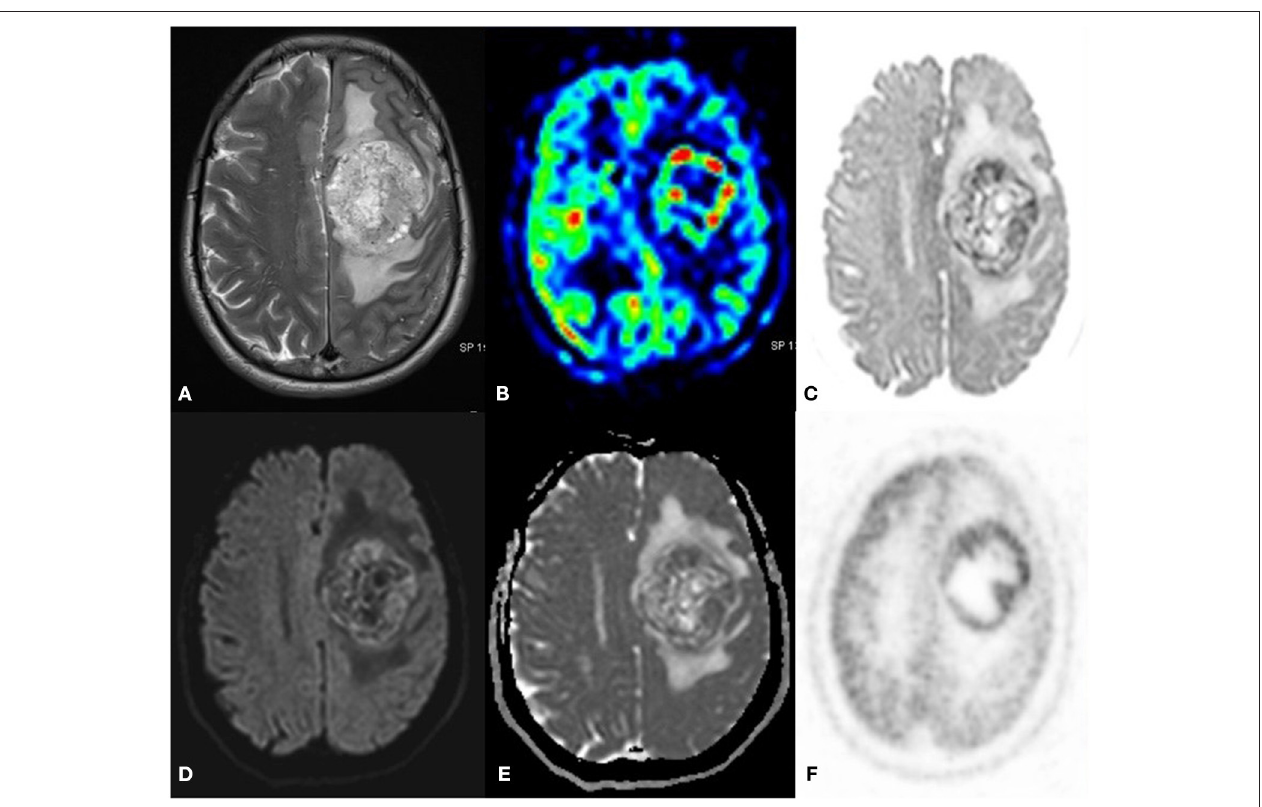
FIGURE 4 | A 55 year old male with a progressive right-side weakness for one and a half month, MRI FDG PET axial images T2 (A) ASL (B) Inverted DWI (C) DWI b2000 (D) ADC (E) NAC PET (F) showed a well-defined lobulated T2 heterogeneous iso- hyperintense with increased perfusion on ASL. The lesion shows DWI restriction with hypermetabolism on PET. There is a match on the inverted DWI image and the NAC PET image. HPE is suggestive of Anaplastic